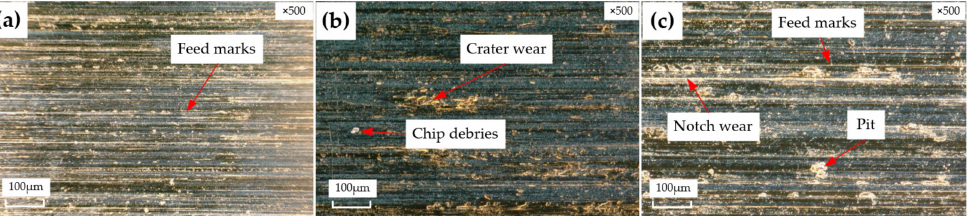
Figure 8. Surface morphologies reamed by Tool B with KEYENCE microscope, ( a ): v = 60 m/min, f = 0.4 mm/rev; ( b ): v = 60 m/min, f = 0.5 mm/rev; ( c ): v = 60 m/min, f = 0.6